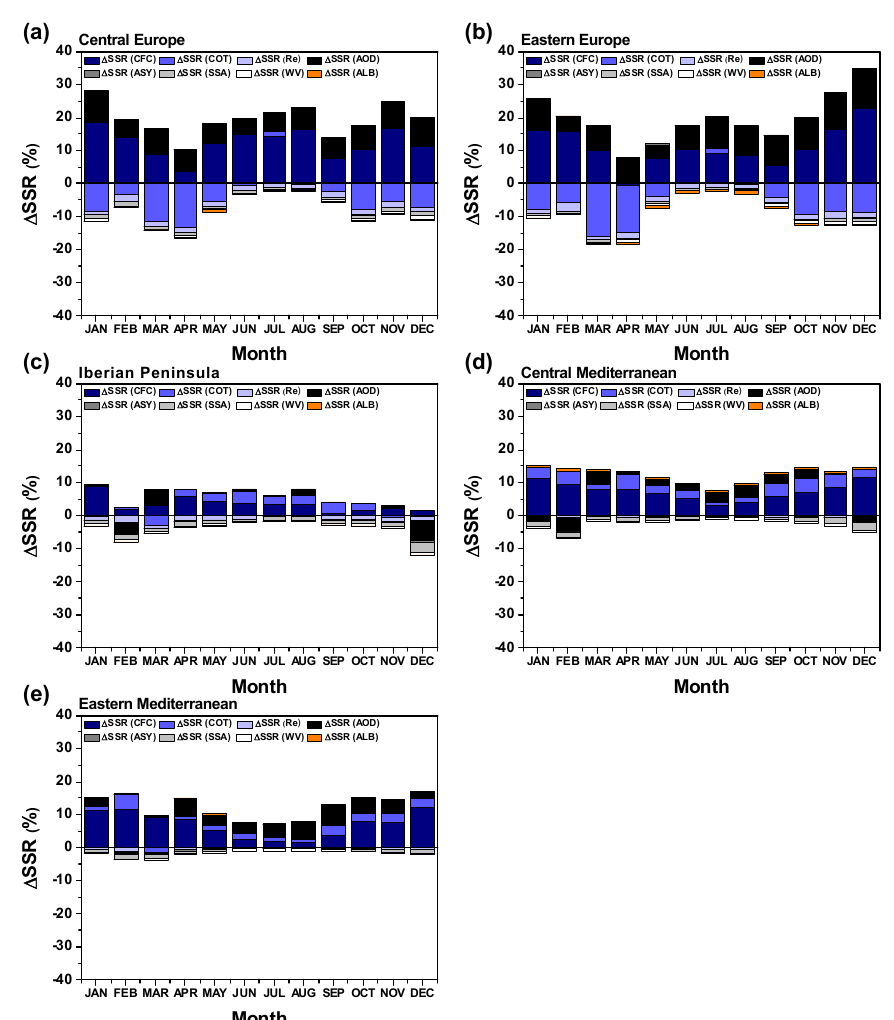
Figure 10. (cid:49) SSR (%) caused by CFC, COT, Re, AOD, ASY, SSA, WV and ALB for (a) CE, (b) EE, (c) IP, (d) CM and (e) EM.